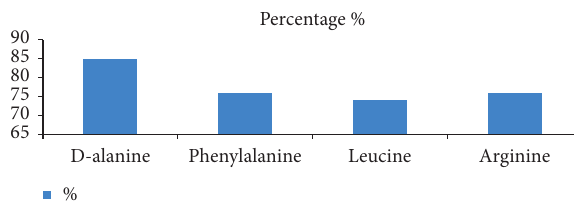
Figure 10: Amino acid utilization of chickpea rhizobial